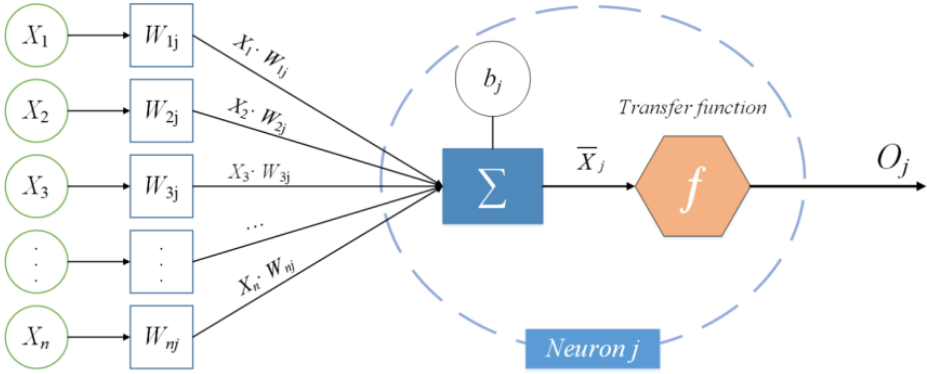
Figure 1. An artificial node used in the ANN system.